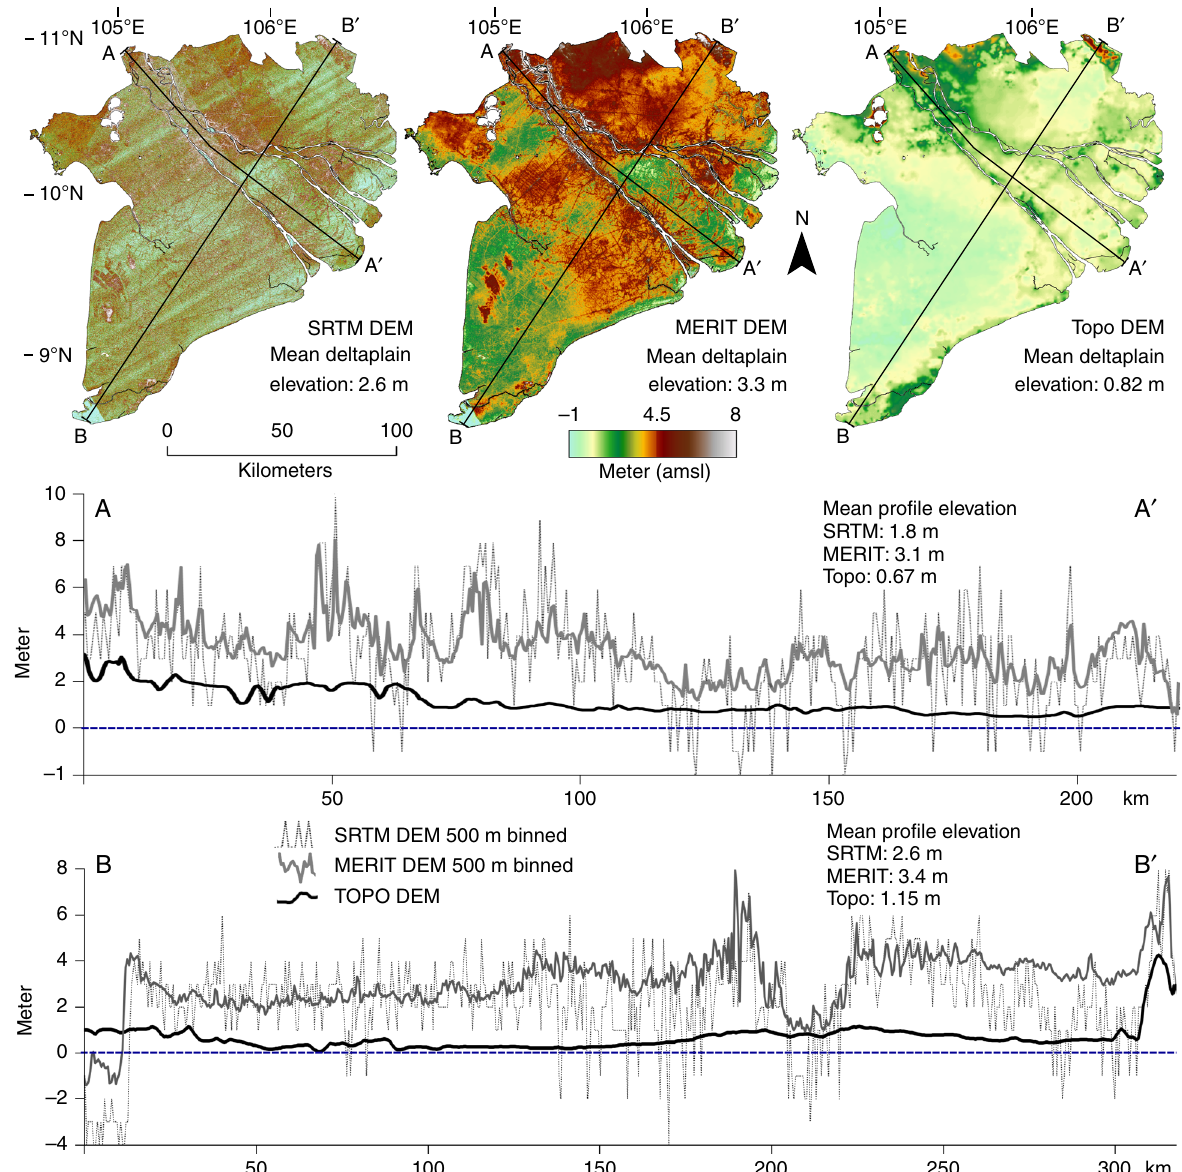
Fig. 3 Digital elevation models of the Mekong delta with elevation pro fi les. The elevation pro fi les of the SRTM and MERIT Digital Elevation Models (DEMs) was binned (mean elevation) in 500-m segments to match the spatial resolution of the Topo DEM to allow visual comparison. Mean elevation of the DEMs was calculated for the delta plain only, excluding the higher elevated bedrock outcrops in the northwest of the delta. Supplementary Fig. 3 is a